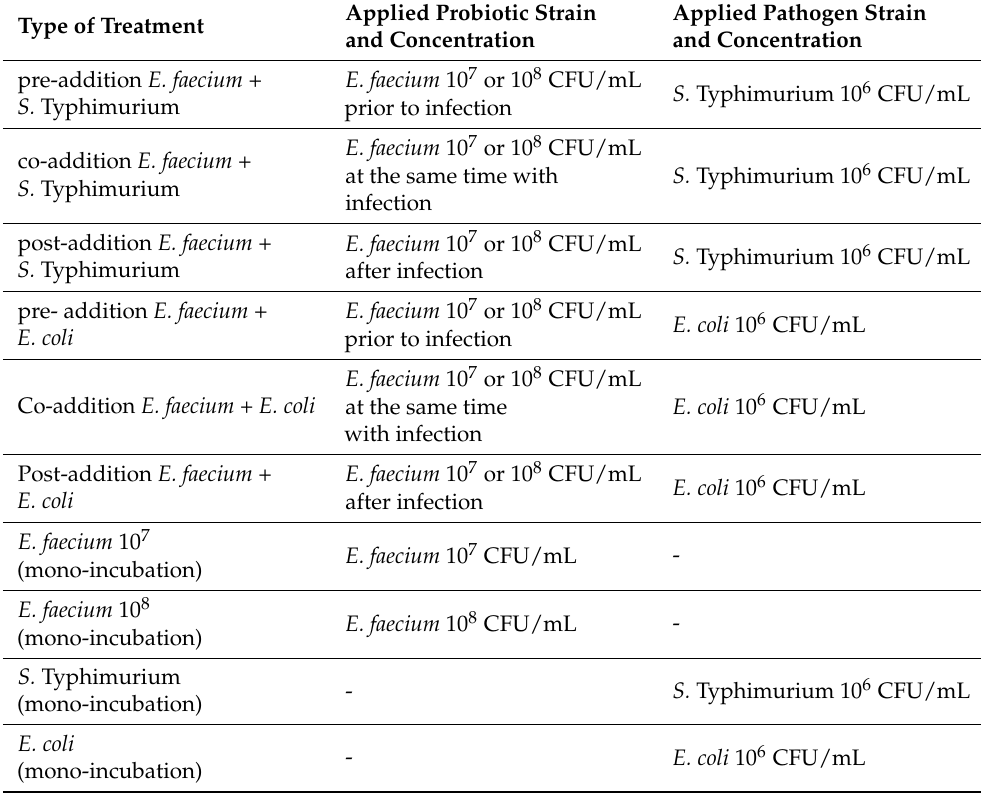
Table 1. Applied treatment types in the co-culture